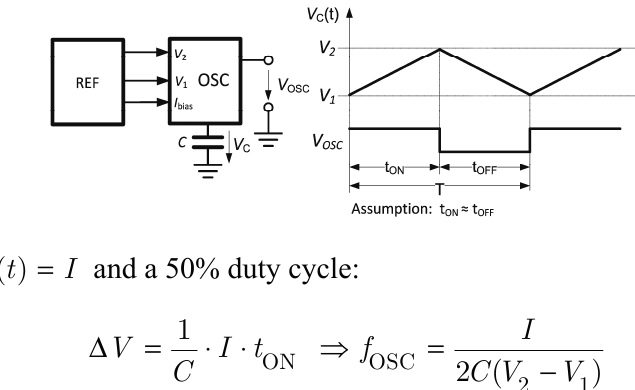
Figure 2. Triangular waveform on the capacitor and output waveform as a function of time. The duty cycle is assumed to be